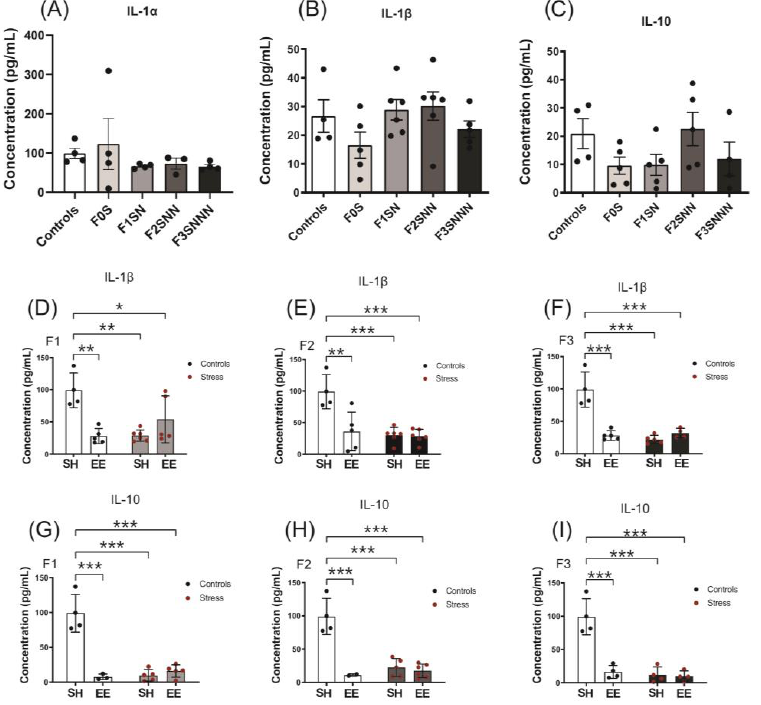
Figure 13. The concentrations of IL- 1α, IL - 1β, and IL -10 were unchanged between control and groups in uterine tissues. The IL-1 β and IL-10 concentrations were increased in the control stressed groups in uterine tissues. The IL- 1β and IL -10 concentrations were increased in the control